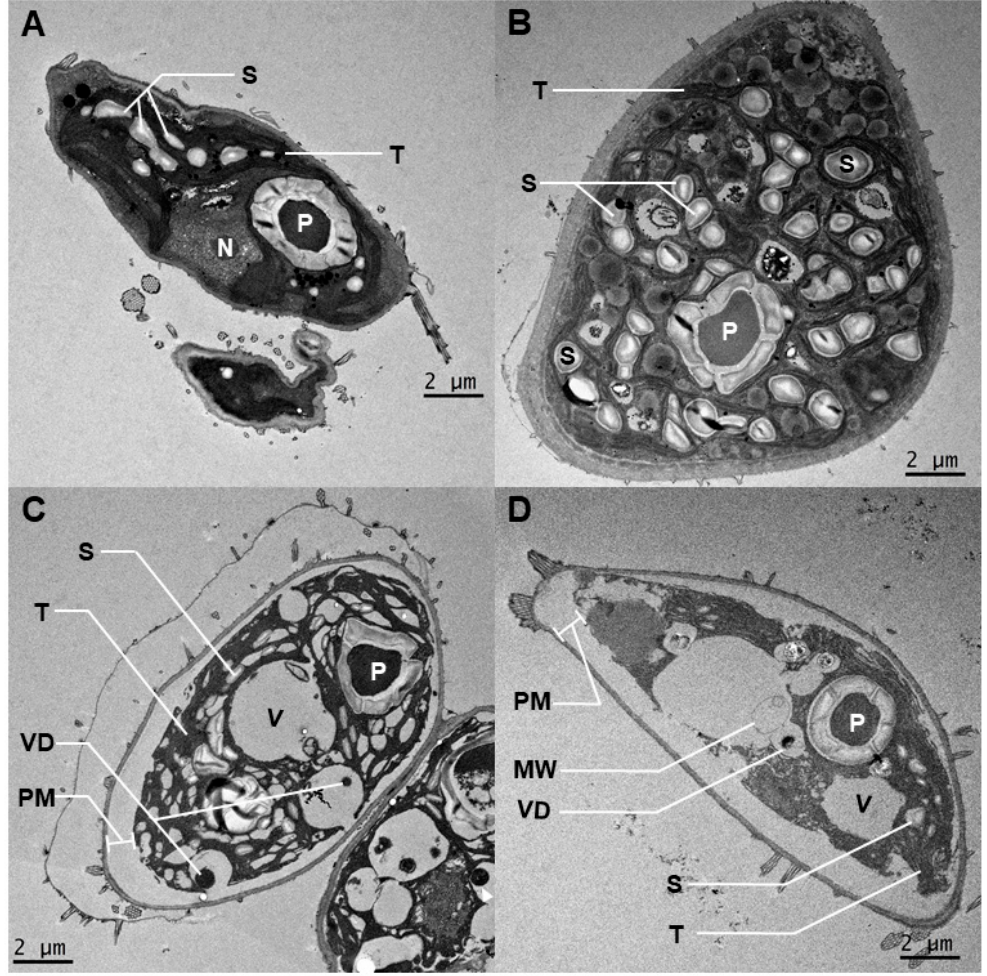
Figure 3. Electron micrographs of Desmodesmus sp. AARLG074 after 24 h growth in JM media at pH 4 and pH 6 at various Cu concentrations. The ultracellular structure of Desmodesmus sp. AARLG074 cultivated in the 0 mg Cu/L media at pH 4 ( A ) and pH 6 ( B ). Numerous starch granules (S) were observed. The ultrastructure of Desmodesmus sp. AARLG074 that grew in 50 mg Cu/L supplemented media at pH 4 ( C ) and pH 6 ( D ). Abbreviations: P, pyrenoids; PM, periplasmic space; S, starch granule; TH, thylakoids; V, vacuole; VD, vacuole deposit.